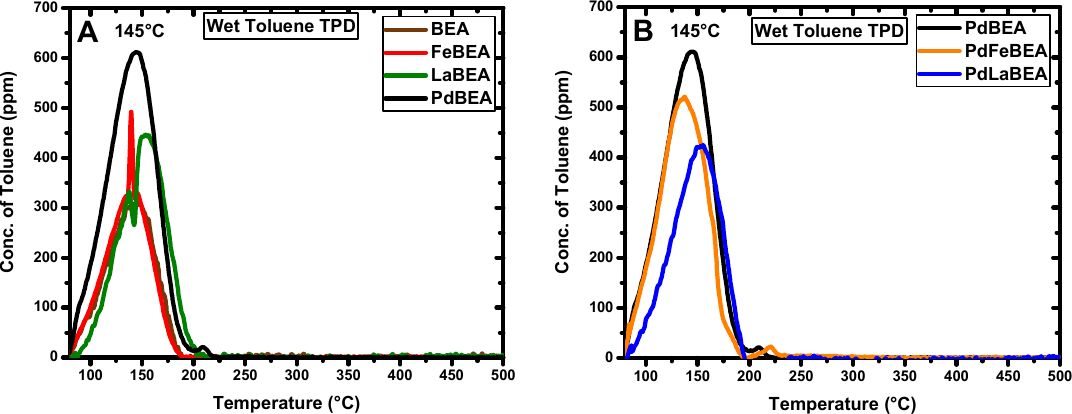
Figure 8. Temperature-programmed desorption of toluene in wet conditions where the concentration of toluene is plotted against the corresponding desorption temperature for ( A ) BEA, Fe / BEA, La / BEA, and Pd / BEA; and ( B ) Pd / BEA, Pd / Fe / BEA, and Pd / La / BEA.